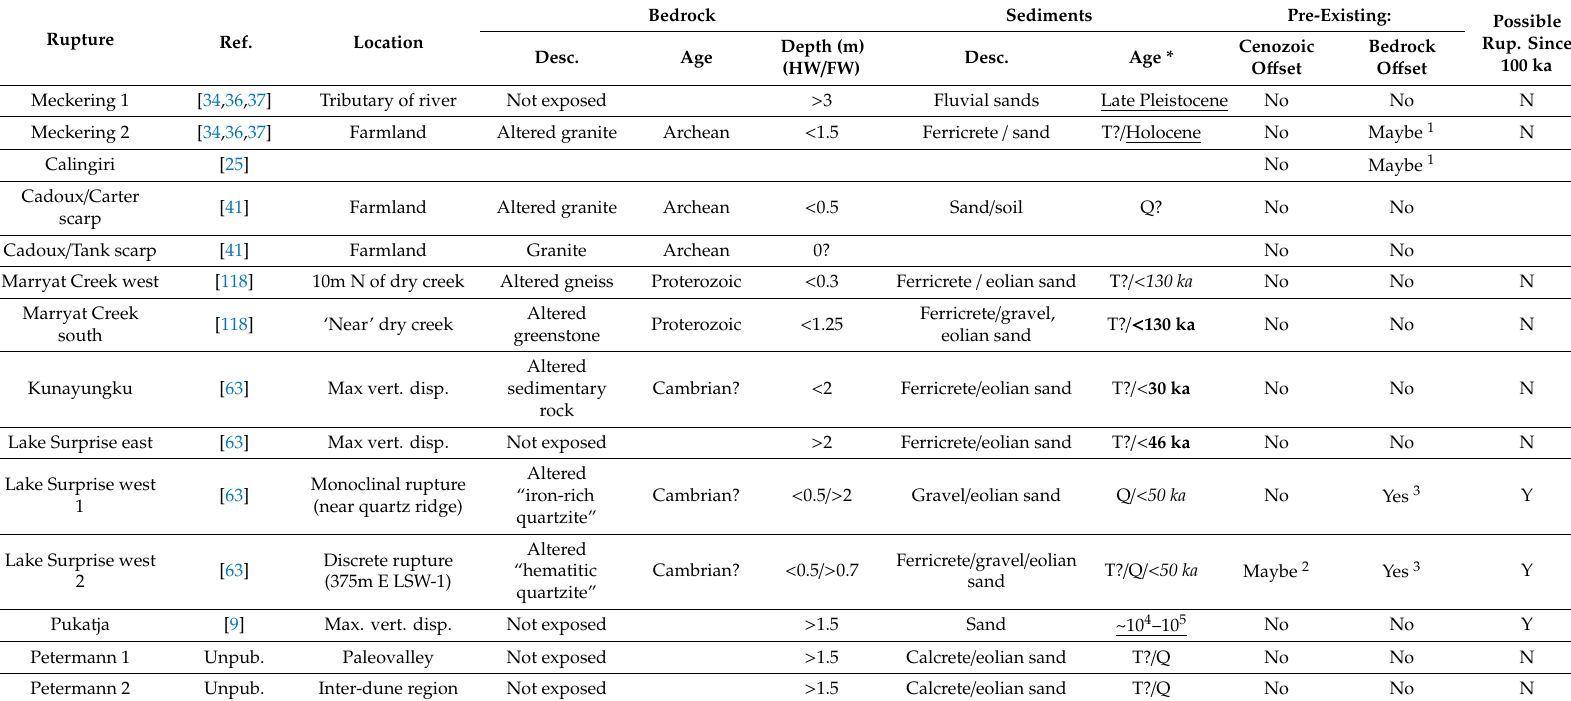
Table 8. Summary of available paleoseismic